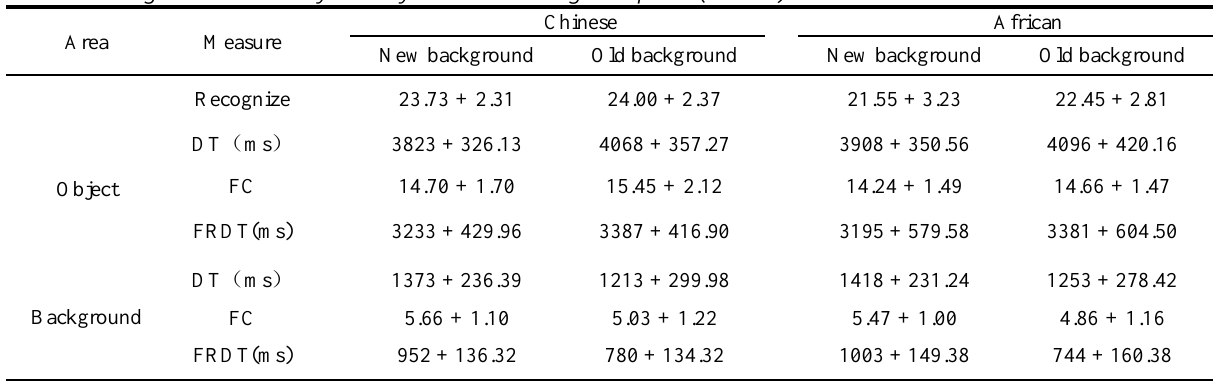
Table 2. Recognition score and eye data by condition in recognition phase (M + SD)